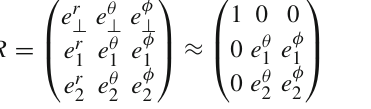
and the inverse rotation back into the polarization states (step 3). In the supplements of the paper, we provide videos detailing how the pulse shapes propagate for different